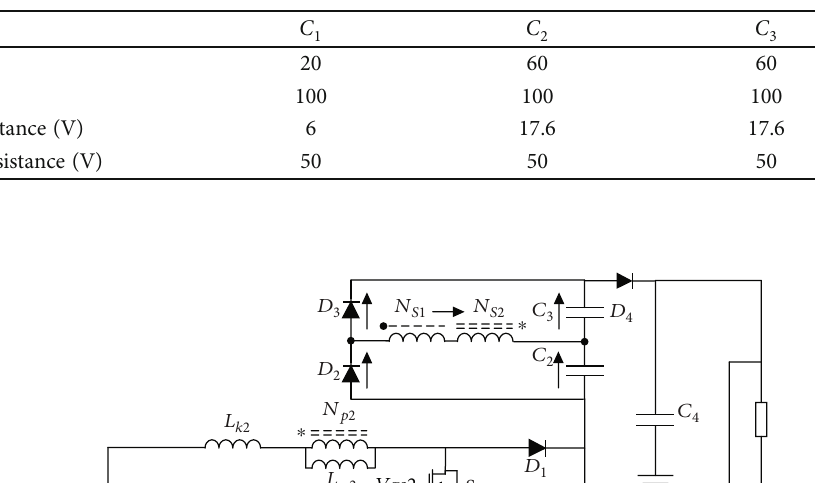
Table 2: Comparison of capacitance theory and actual values.